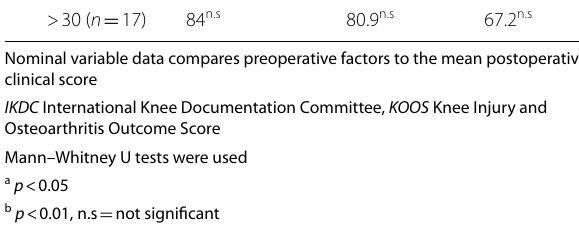
(Table 2). There were no cases of progression to K-L grade 4. Bone marrow oedema signal significantly improved on follow-up MRI ( p < 0.01). Five knees (15%)